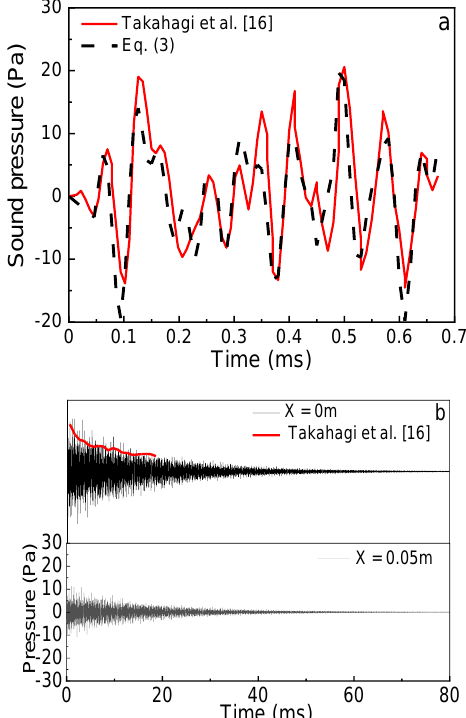
Fig. 1 Acoustic emission signals of steel particle impact with steel plate experiment [16] ( ) and acoustic model (--): (a) short time scale; (b) long time scale of different sensor